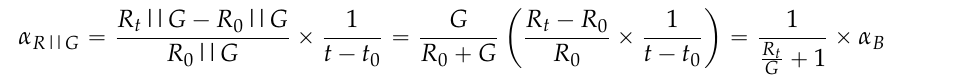
Figure 3. Parallel connection for compensation of the bridge offset output voltage.